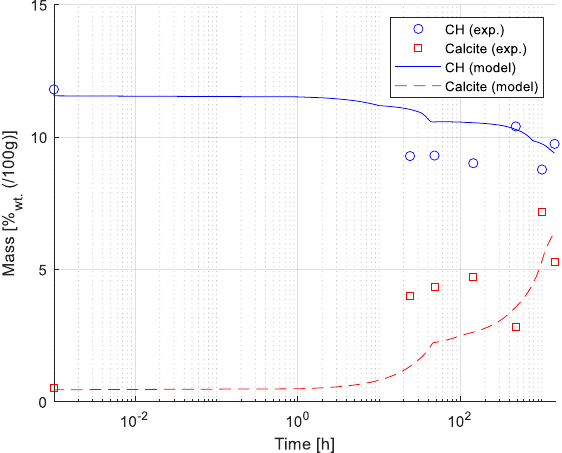
Figure 6. Comparison between model and experimental results for Portlandite (CH) and Calcite. Results presented correspond to the mass fraction (in wt.% of total mass) of Portlandite and Calcite (shown in linear scale) during the exposure time (shown in logarithmic scale). Experimental data is derived from TGA measurements (see also Figure 1).